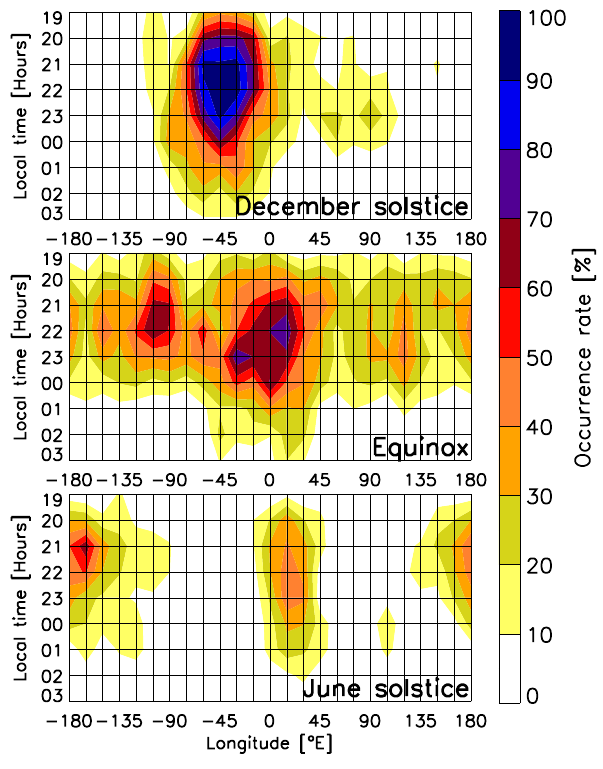
Fig. 7. Longitudinal variations of the occurrence rate of CHAMP ESF signatures for different local times and